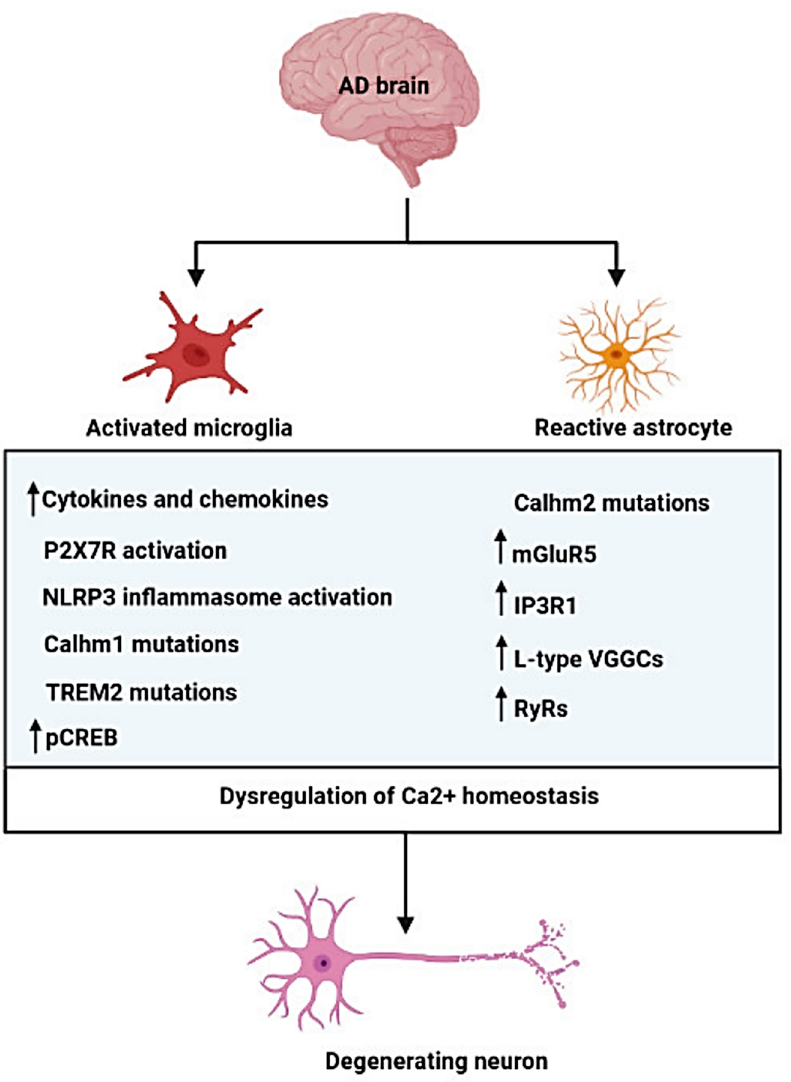
Figure 2. Schematic representation of Ca 2+ homeostasis dysregulation in microglia and astrocytes in AD. P2X7R, purinergic P2X7 receptor; NLRP3, NOD-like receptor pyrin domain containing 3; Calhm1, Ca 2+ homeostasis modulator family member 1; TREM2, triggering receptor expressed on myeloid cells 2; pCREB, phosphorylated cAMP response element binding protein; Calhm2, Ca 2+ homeostasis modulator family member 2; mGluR5, metabotropic glutamate receptor 5; IP3R1, Inositol 1,4,5-trisphosphate (IP3) receptor type1; L-type VGGCs, L-type voltage-gated Ca 2+ channels; RyRs, Ryanodine receptors. Created with BioRender.com; accessed on 29 July 2022.